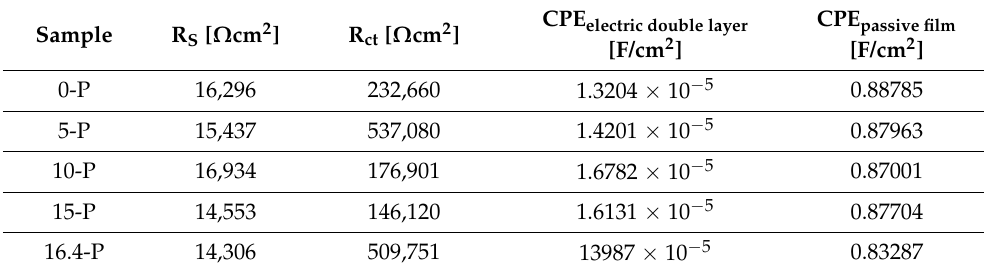
Table 3. Parameters of equivalent electrical circuits determined for the five tested materials.